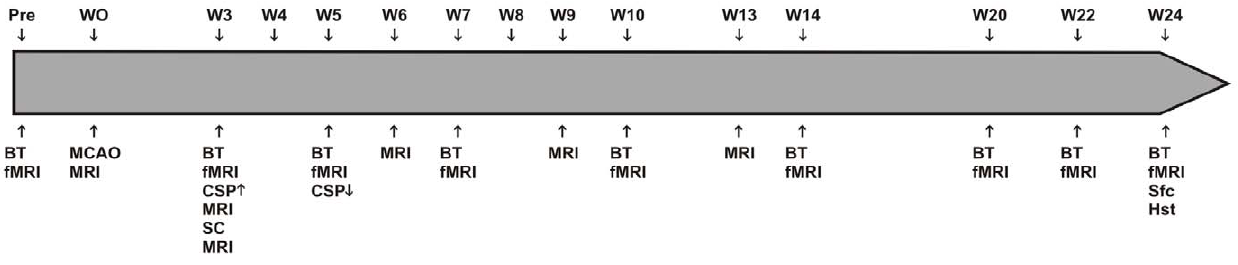
Figure 1. Time schedule of the experimental procedures. BT: behavioral testing, CSP: Cyclosporin application, fMRI: functional MRI study, Hst: histology, MCAO: middle cerebral artery occlusion, i.e. stroke induction, MRI: 3D high-resolution T2*-weighted MRI, SC: stem cell implantation, Sfc: sacrifice, W: week.